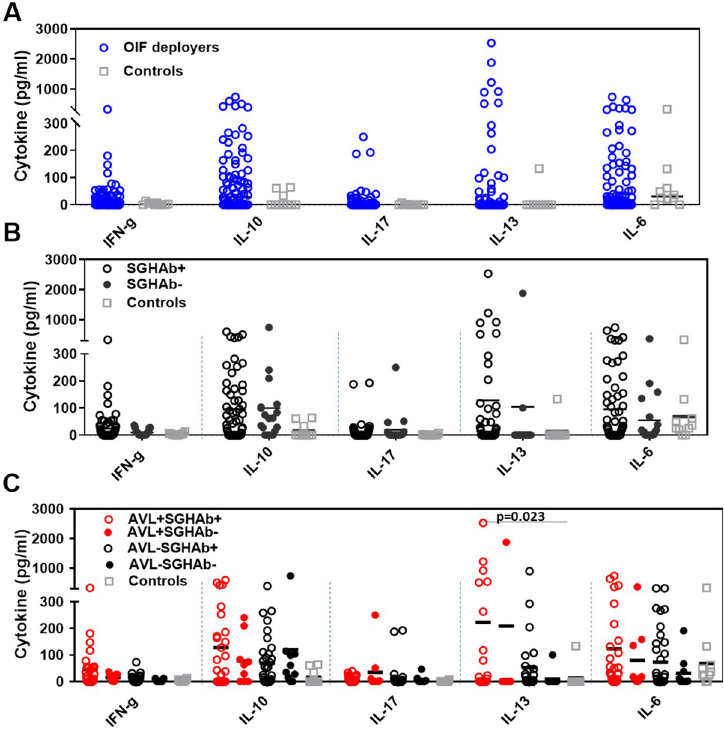
Fig 2. Cytokine levels induced by Ph . alexandri salivary gland homogenate after 96 hours stimulation. Unless specifically shown, none of the comparisons reached statistical significance. (A) Response in OIF deployers (open blue circles) versus never traveled controls (open grey squares). (B) Response in SGHAb + (black open circles), SGHAb - deployers (solid black circles) and never traveled controls (open grey squares). (C) Response in AVL + SGHAb + (open red circles), AVL + SGHAb - (solid red circles), AVL-SGHAb + (open black circles), AVL-SGHAb - versus never traveled controls (open grey squares). Cytokines were quantified by ELISA in the culture supernatants of PBMCs stimulated with Ph . alexandri salivary gland extract (1 ug/ml) during 96h. The significance of differences between groups was evaluated by the Mann-Whitney test. P values of < 0.05 were considered significant. Horizontal lines represent mean values.